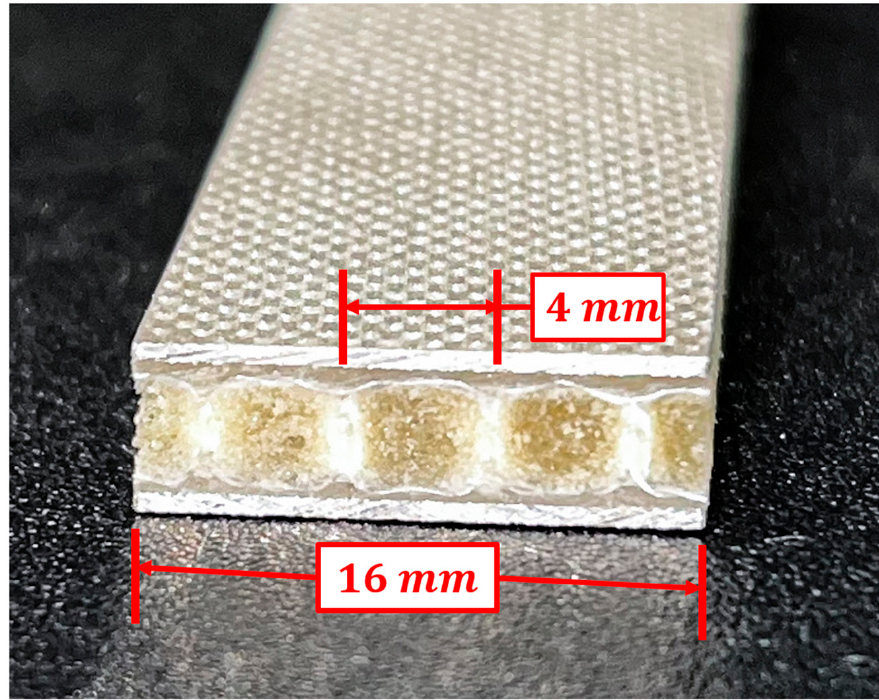
Figure 4. Customized compression test specimen width for 3DFML.